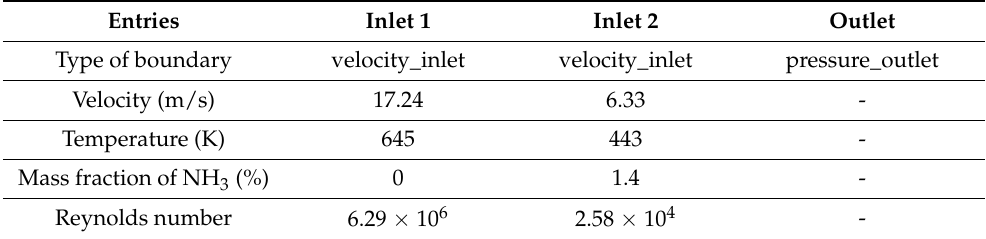
Table 1. Boundary conditions of the CFD